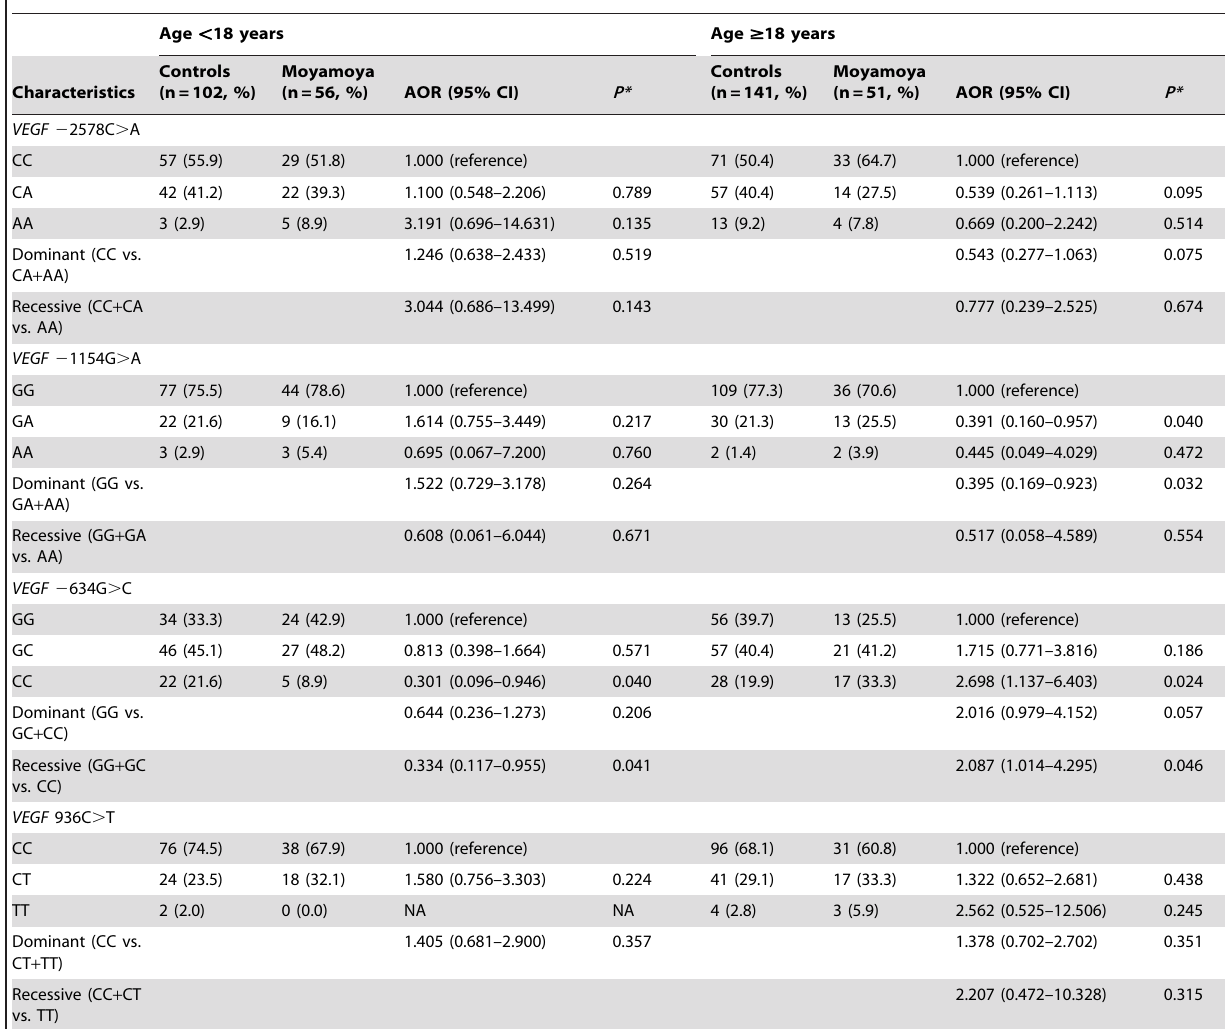
Table 4. The frequency of the VEGF polymorphisms according to